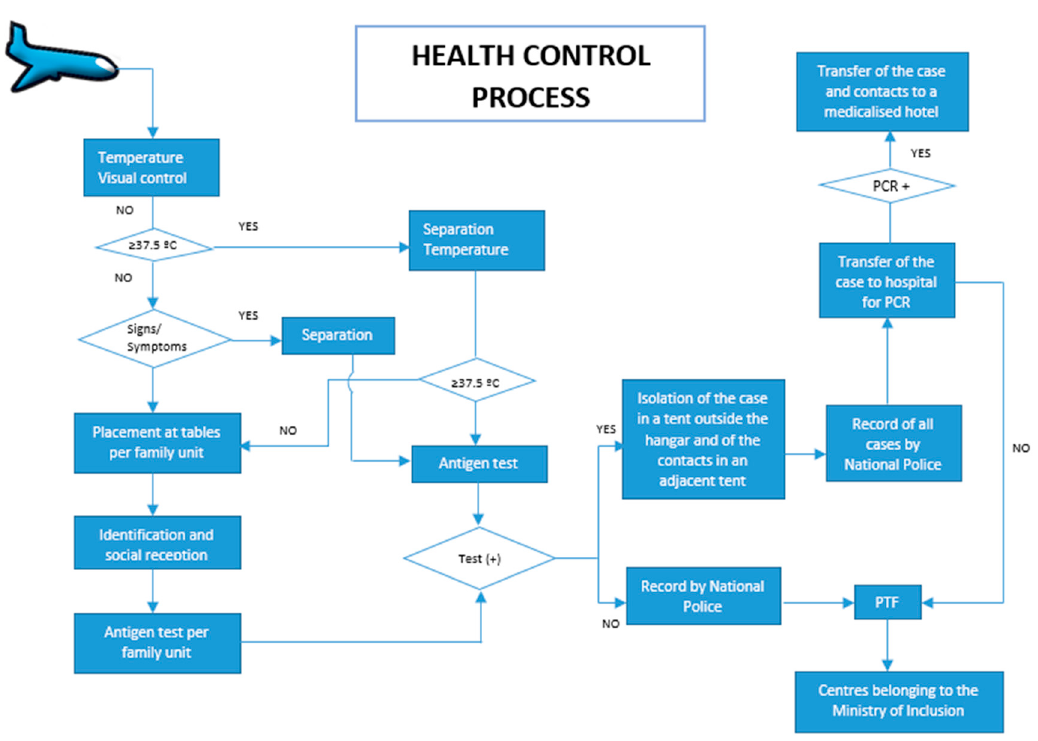
Figure 2. Procedure for health control on arrival. PCR: polymerase chain reaction. PTF: provisional transit